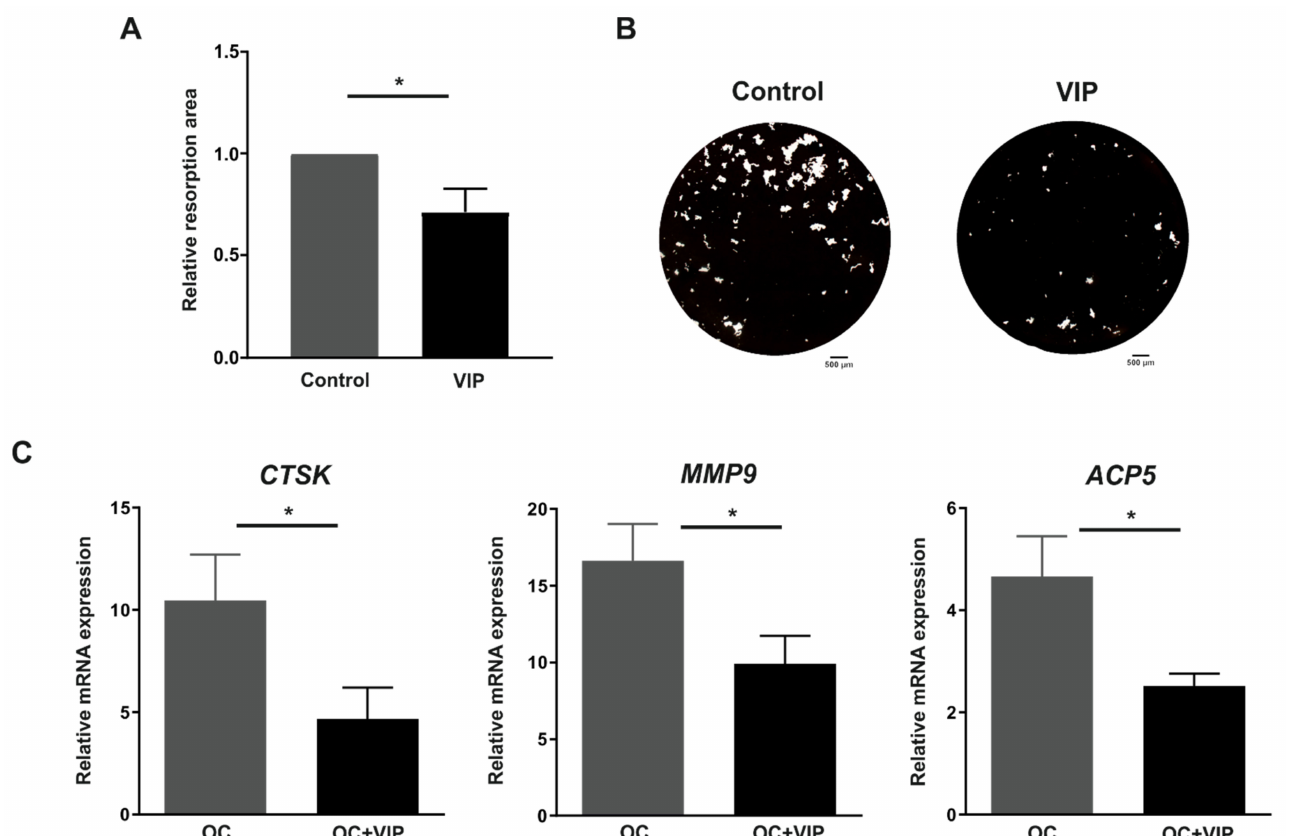
Figure 4. Osteoclast resorptive activity in vitro is decreased by VIP. After 14 days of in vitro differentiation on OsteoAssay ® Surface Multiple Well Plate in presence or absence of VIP 10 − 8 M, wells were stained by Von Kossa staining and resorption area was quantified. ( A ) Effect of VIP on resorption area generated by mature osteoclast. Results are presented as percentages relative to the control (mature osteoclasts). ( B ) Photomicrographs of resorption areas formed by osteoclasts differentiated in the absence (control) or presence of VIP (VIP). ( C ) CTSK , MMP9 and ACP5 mRNA expression levels in differentiated osteoclasts in absence (OC) or presence of VIP 10 − 8 M (OC+VIP) was determined by real-time PCR. Results are expressed as relative mRNA expression (relative to GAPDH levels). The means ± SEM of triplicate determinations of 12 independent experiments are shown. Mann–Whitney U test was performed (* p <